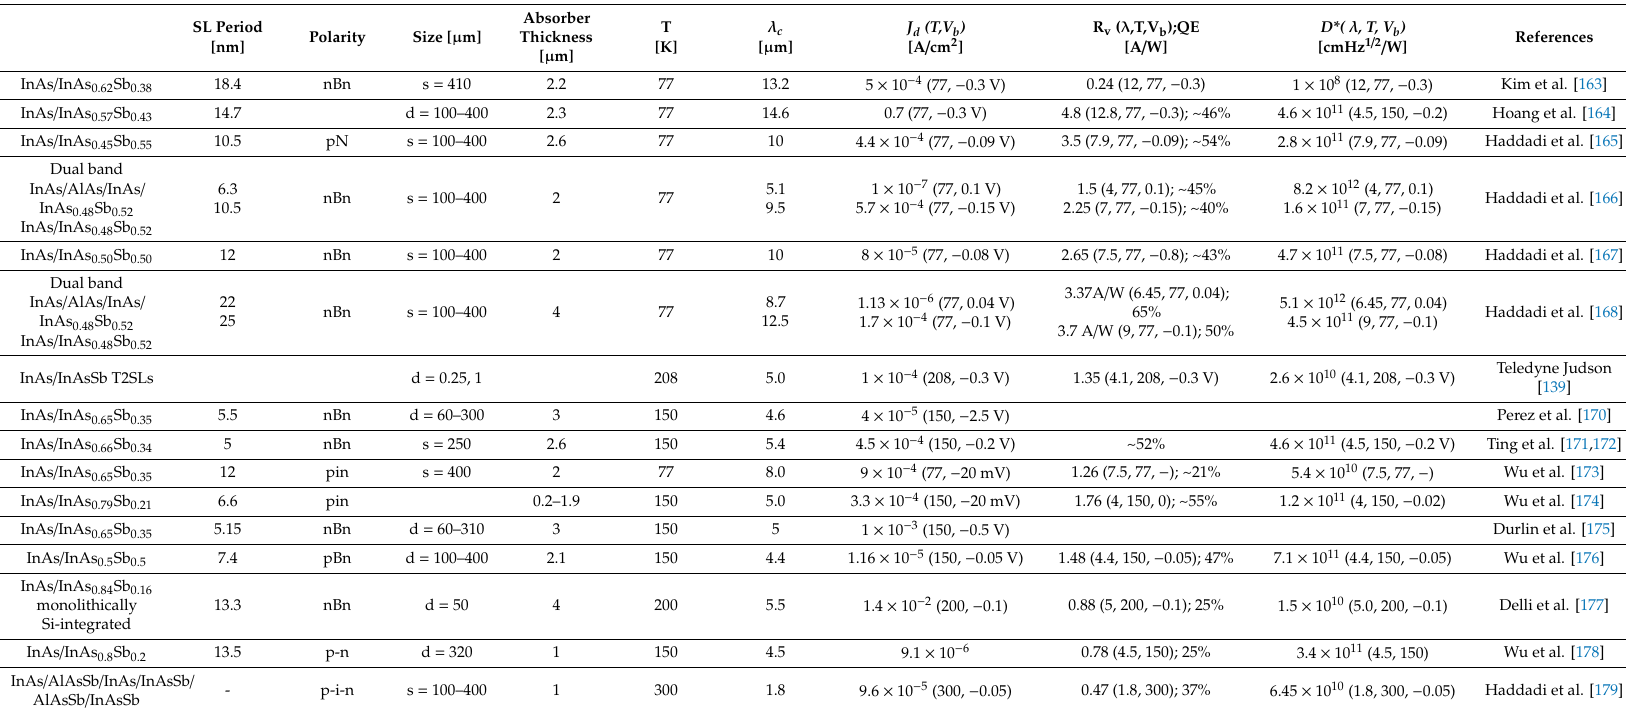
Table 4. InAs / InAsSb superlattice infrared